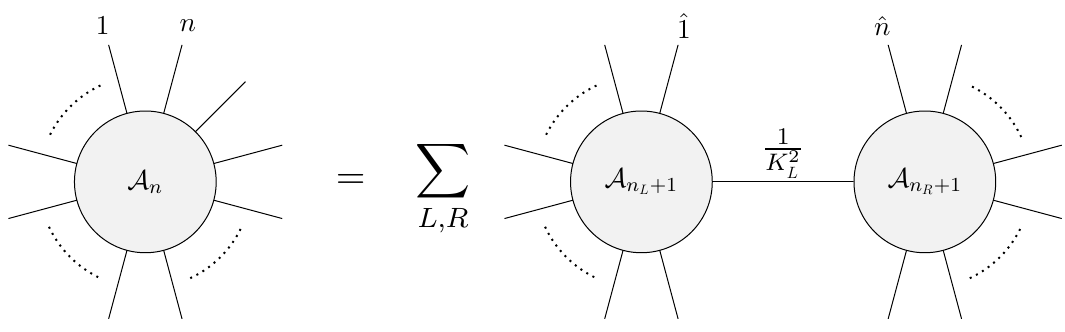
Figure 2 . A diagrammatic representation of the BCFW relation